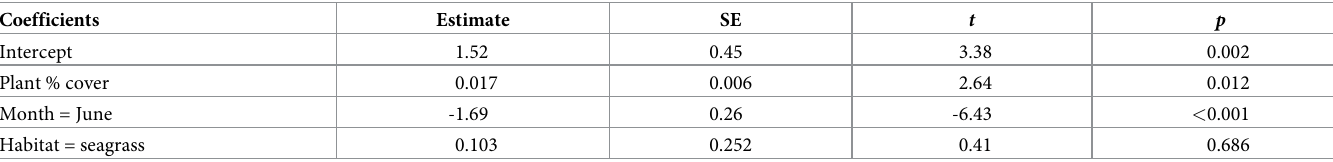
Table 7. Summary of GLM for model g 2 predicting crab density, including parameter estimates, standard errors (SE), t values and p values. The intercept represents August Gracilaria . Model g 2 explained 52.2% of the null deviance.